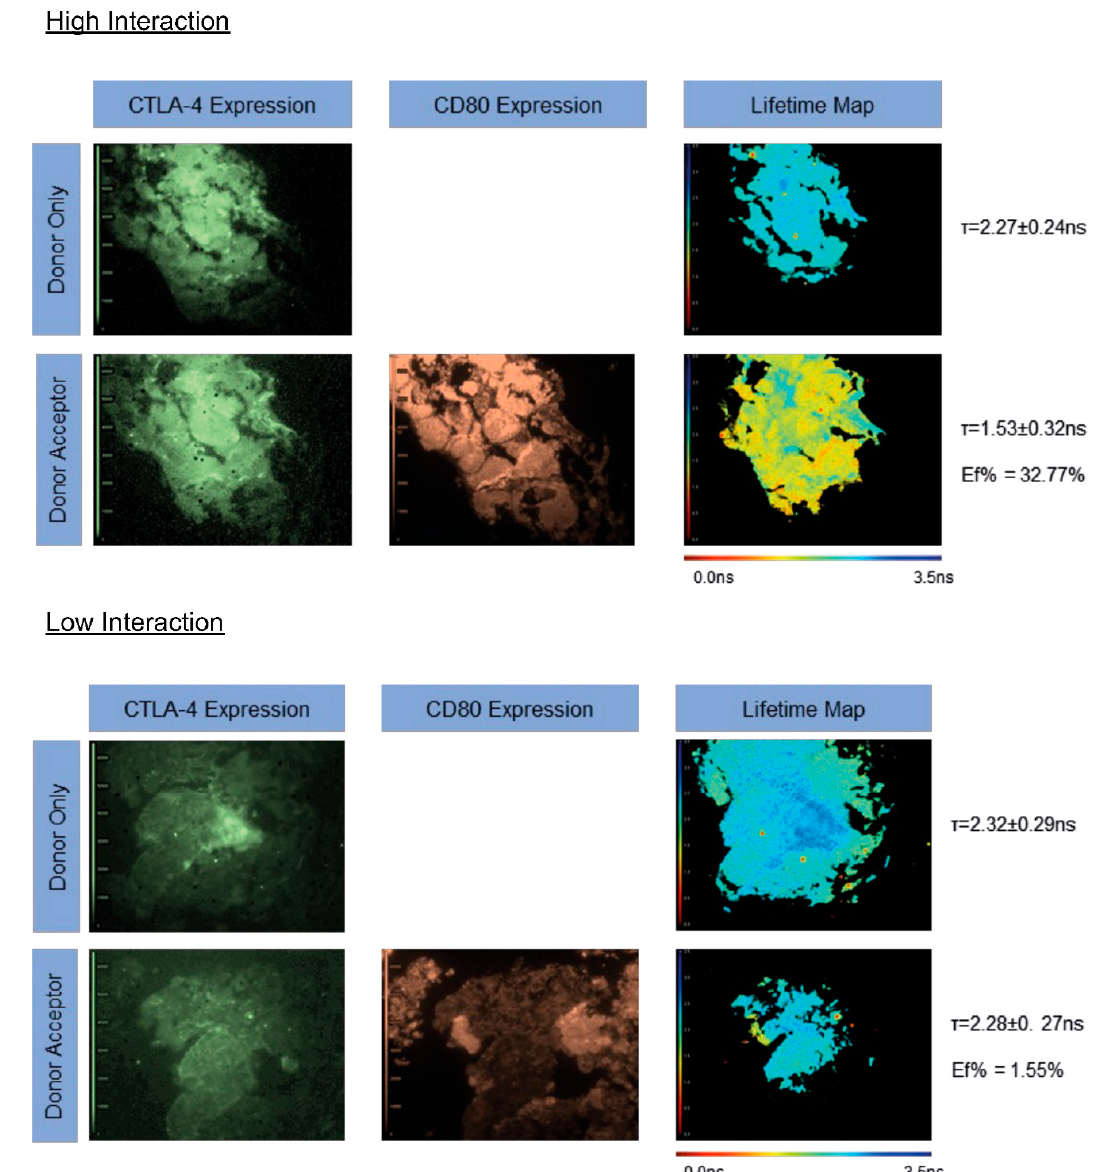
Figure 1. iFRET quantifies high and low PD-1/PD-L1 interaction states in lung metastases, detecting inter- and intratumoral heterogeneity. Representative FLIM images demonstrating high and low CTLA-4/CD80 interaction states. Top panel: greyscale images indicate CTLA-4 or CD80 expression in donor-only or donor-acceptor tissue slices for one patient. No difference is observed between CTLA-4 expression between the donor-only and donor-acceptor slides. The lifetime map indicates the mean lifetime per pixel of an image. The donor only lifetime (2.27 ± 0.24 ns) is represented by blue/green in the pseudo-color scale. In the donor-acceptor slide, the lifetime of the donor is reduced to 1.53 ± 0.32 ns, yielding a FRET efficiency of 32.77%. This is indicative of a high CTLA-4/CD80 interaction state. Bottom panel: here, a good expression of CTLA-4 and CD80 are observed and no significant differences in expression profiles are seen between the top and bottom panels. The donor-only lifetime here is 2.32 ± 0.29 ns, which is reduced to 2.28 ± 0.27 ns in the presence of the acceptor, giving a FRET efficiency of 1.55%. This indicates that CTLA-4/CD80 are undergoing little to no interaction in this sample, despite the presence of both receptor and ligand. Critically, in both examples, high tissue level coincidence is observed between the donor-only and donor-acceptor slices, meaning that donor lifetime changes are due to the presence of the acceptor chromophore and are not reporting on intratumoral